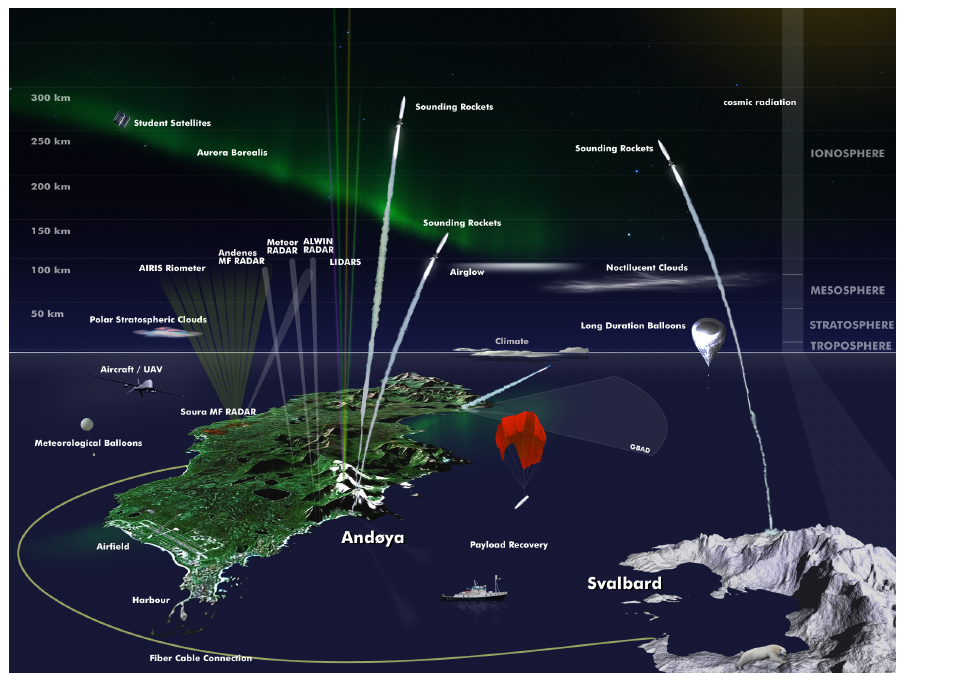
Figure 14. Overview of the infrastructure of ARR/ASC with SvalRak.